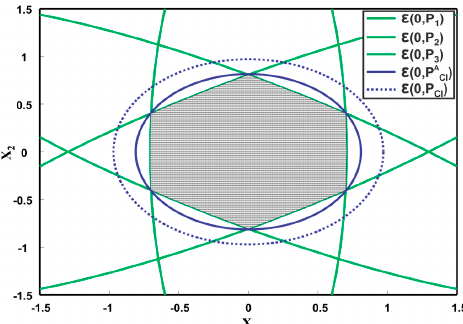
Figure 12. Illustration of three ellipsoids ε ( 0,P 1 ) , ε ( 0,P 2 ) , ε ( 0,P 3 ) and their fusion result ε ( 0,P CI ) , ε(0,P